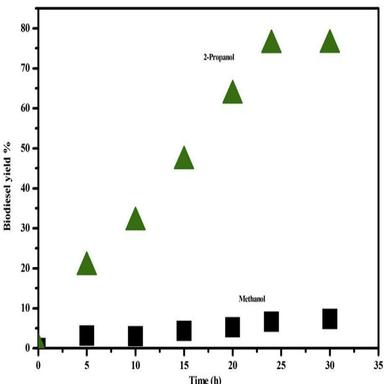
Effect of alcohols (methanol and propan-2-ol) on production of biodiesel at several reaction parameters: 50±1 C, 10% hybrid BSC on oil amount, 24 h, 1:6 Castor oil to ratio alcohol.